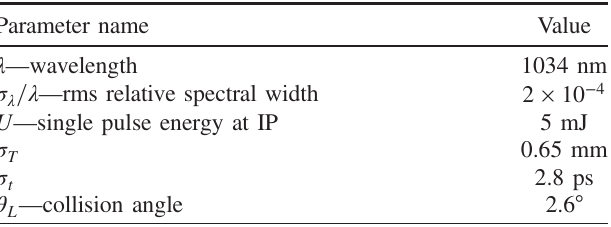
TABLE II. Laser parameters for the Gamma Factory POP experiment. The wavelength is given by the choice of the ion species and the availability of high power systems. The single pulse energy U and pulse duration σ t are determined to maximize the number of excited atoms at each bunch crossing, see Ref. [13] for details. The relative spectral width is obtained from the pulse duration by assuming Fourier limited laser pulses. The crossing angle θ L and the laser-beam rms transverse size of the intensity distribution σ T are constrained by the mechanical implementation and the optical design, respectively, see text for